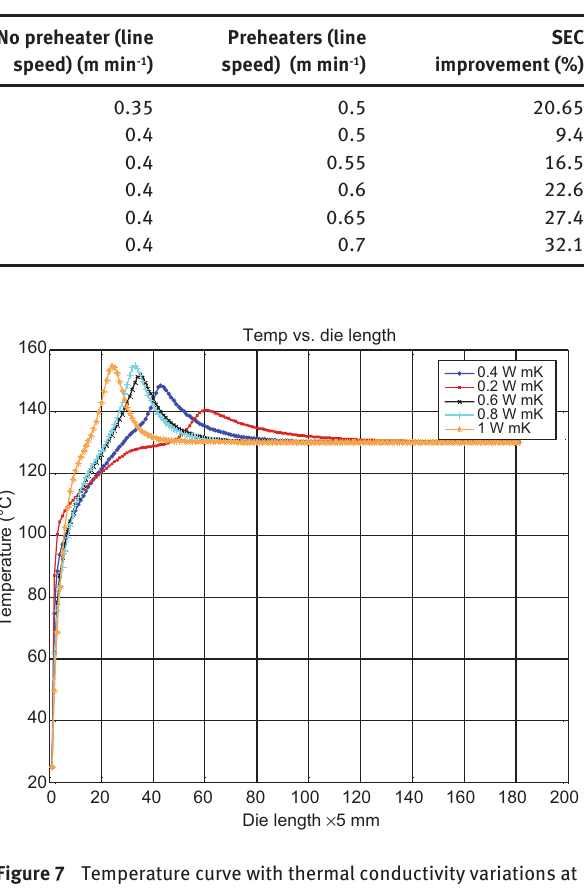
Table 2 SEC comparison for different line speeds and preheaters.